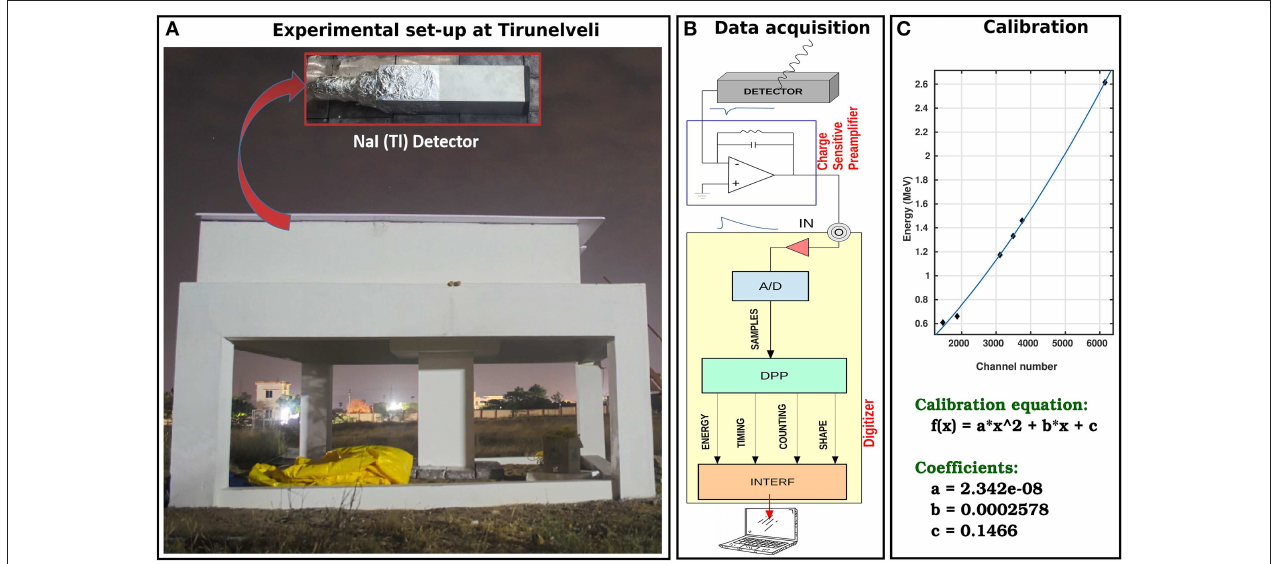
FIGURE 2 | (A) Experimental set-up of NaI (Tl) detector at Tirunelveli, India; (B) Data acquisition system; (C) Energy calibration curve.